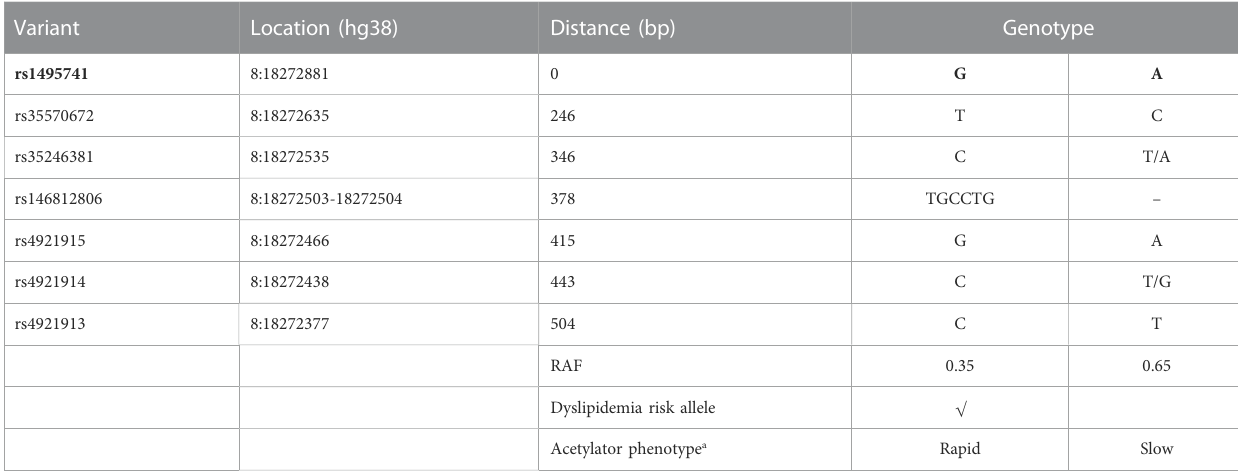
Table S2). For instance, two risk alleles in the dyslipidemia risk haplotype,